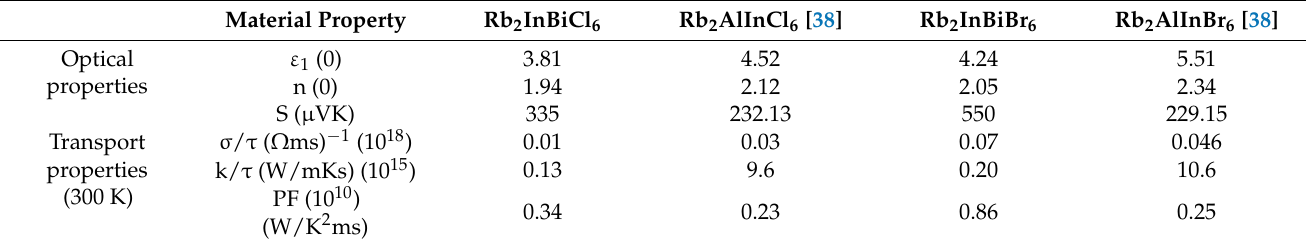
Table 4. Calculated optical and transport properties for double perovskite Rb 2 InBiX 6 (X = Cl, Br) compounds using mBJ approach .